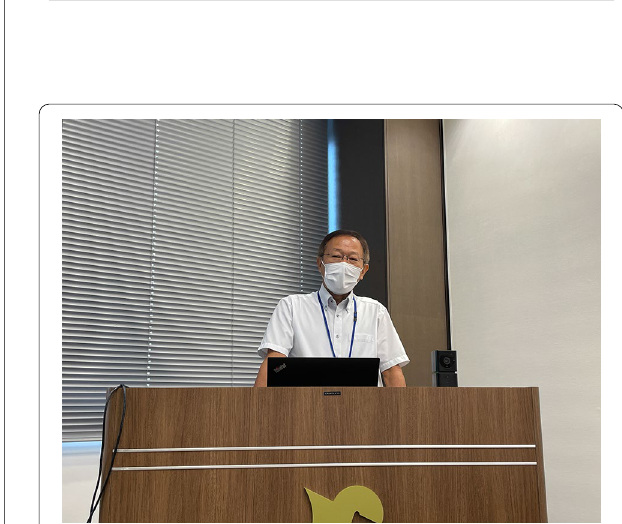
Fig. 4 Keynote Lecture presented by Prof. Emer. Masakatsu